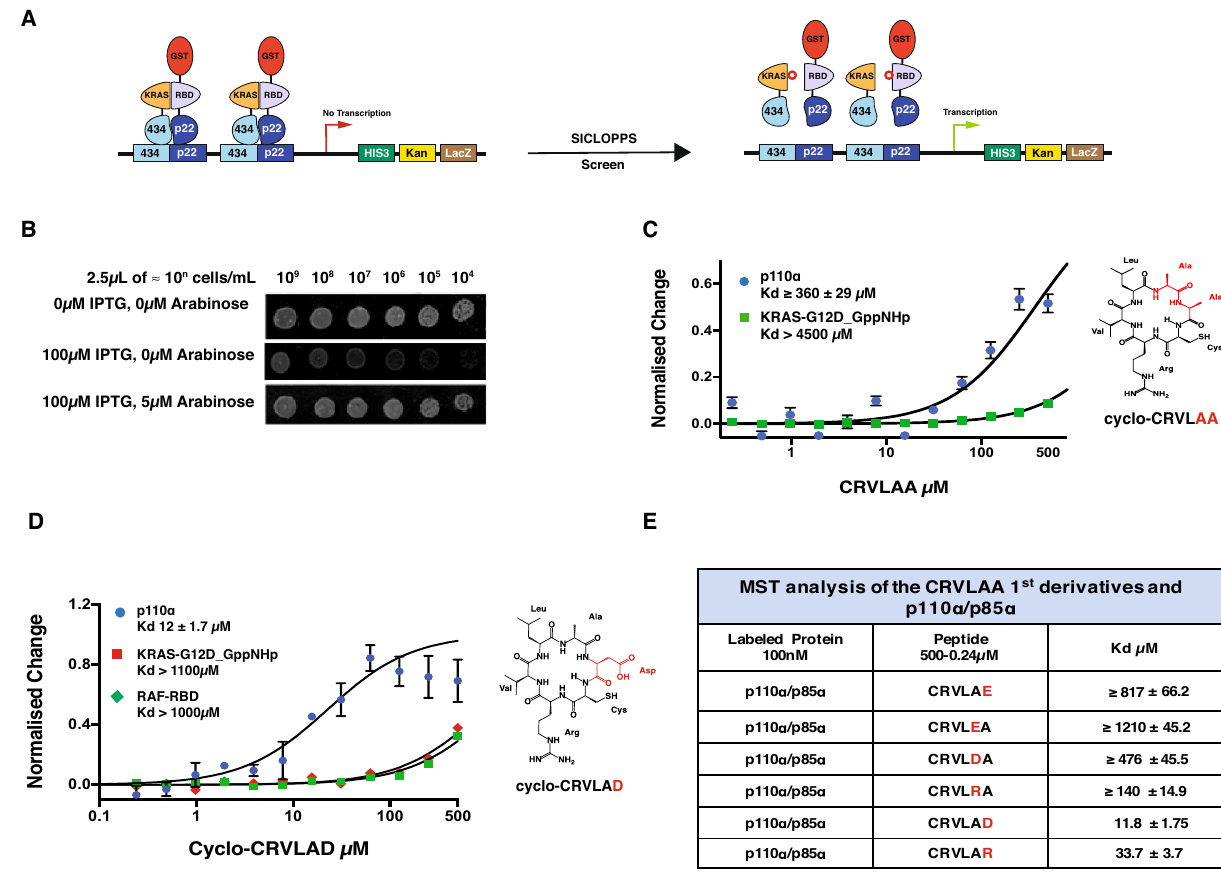
Figure 1. The RTHS and characterisation of cyclo-CRVLAA and its 1st derivatives. ( A ) A schematic presentation of the GST-RBDα/KRAS RTHS. The presence of GST at the N-terminal of the RBDα is to increase the domain’s solubility. The RTHS is controlled by the addition of IPTG which stops the growth of the bacterial cell on selective media upon the interaction between GST-RBDα and KRAS. Growth is recovered if a co-expressed cyclic peptide blocks the GST-RBDα/KRAS interaction by either binding to GST-RBDα or KRAS. ( B ) Bacterial drop spotting of the GST-RBDα/KRAS RTHS: bacteria grow normally in the absence of IPTG (GST-RBDα and KRAS are not expressed) upper lane; in the presence of 100 µM IPTG the RTHS shows lack of growth on higher dilutions, middle lane; in the presence of IPTG and arabinose (which controls expression of the cyclic peptides), where there is a peptide that blocks the protein interaction, the RTHS regains growth on selective media—as in the case with cyclo-CRVLAA bottom lane. ( C ) MST analysis of cyclo-CRVLAA with p110α (p110α/p85α) and KRAS. The cyclo-CRVLAA shows weak binding to p110α but no significant binding to KRAS. ( D ) The peptide derivative cyclo-CRVLAD interacts 30-fold more strongly with p110α than cyclo- CRVLAA but does not interact with KRAS or the CRAF-RBD. ( E ) Table displaying the MST analysis of all the cyclo-CRVLAA 1st derivatives with p110α